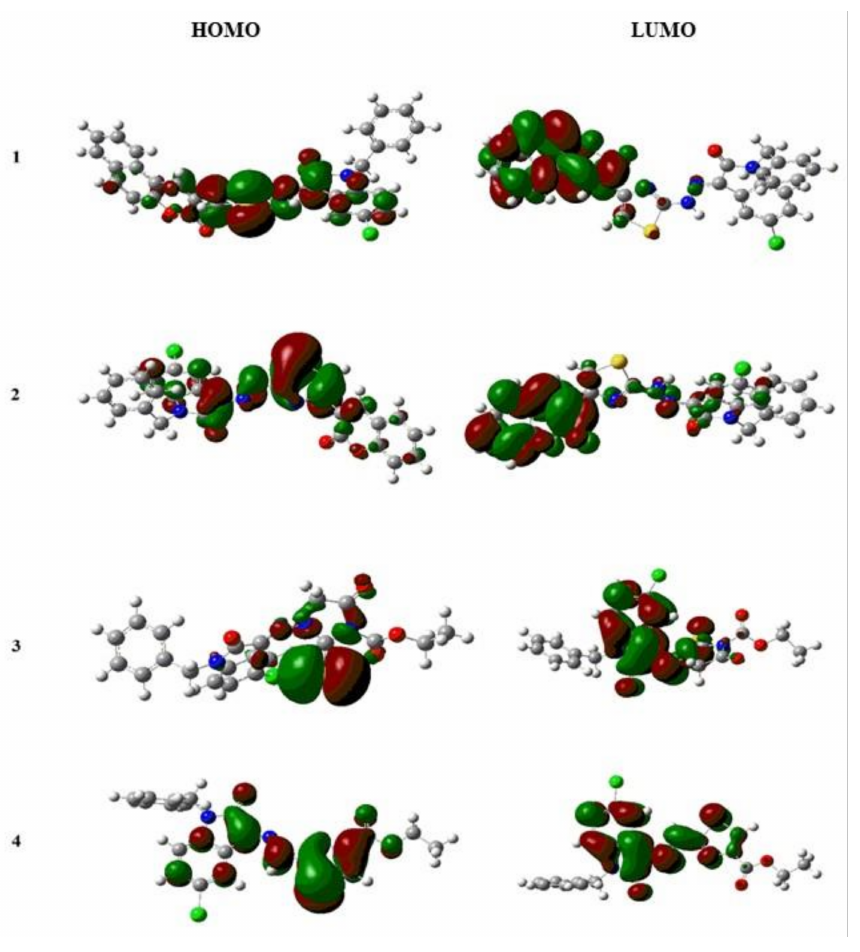
Figure 4. HOMO–LUMO gap for complexes, 1 – 4 : IST-01, IST-02, IST-03, and IST-04. Table 1. Optimized energy and the HOMO–LUMO gap difference determining reactivity of com-